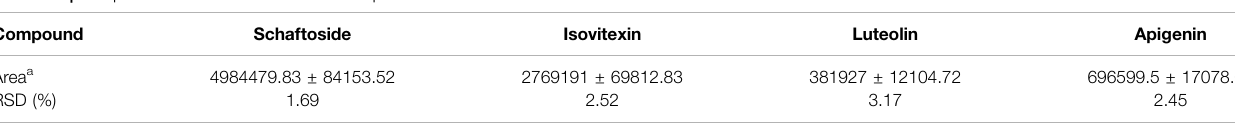
TABLE 1 | The peak area and RSD values of components.